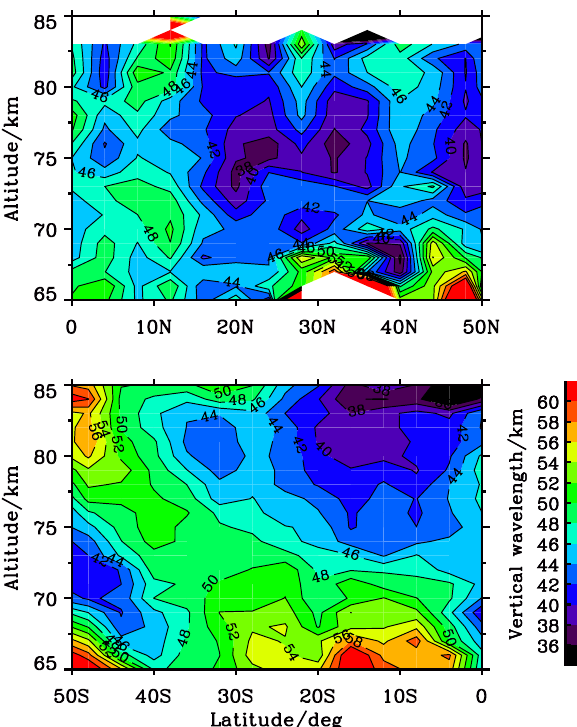
Fig. 10. Latitude–altitude cross sections of averaged vertical wave- lengths for (2.04, W4) (upper) and (2.13, W3) (bottom).